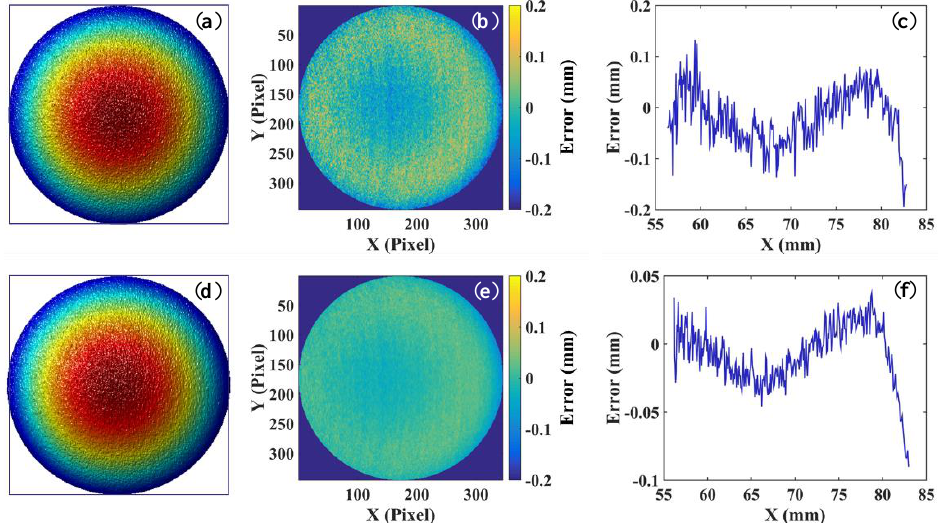
Figure 5. Measurement results of a spherical surface with two methods. ( a – c ) Results with the method requiring projector calibration: ( a ) 3D geometry; ( b ) 2D error map of ( a ); ( c ) cross section of the middle line from ( b ). ( d – f ) Results with our method: ( d ) 3D geometry; ( e ) 2D error map of ( d ); ( f ) cross section of the middle line from ( e ).